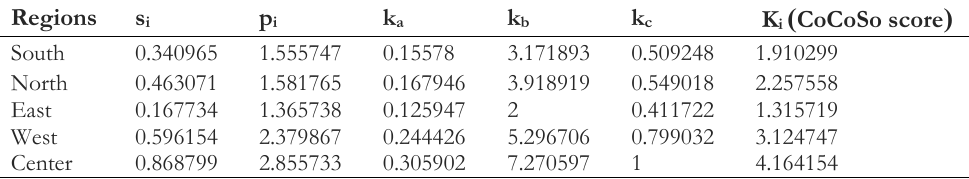
Table 12. The results of CoCoSo